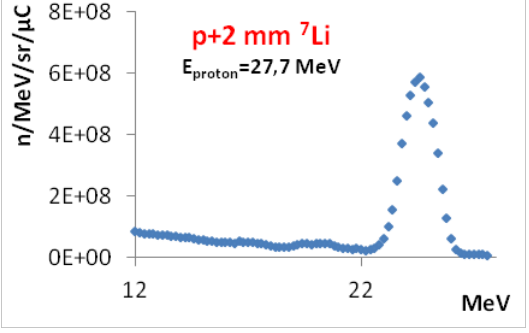
Figure 1. Quasi-monoenergetic neutron